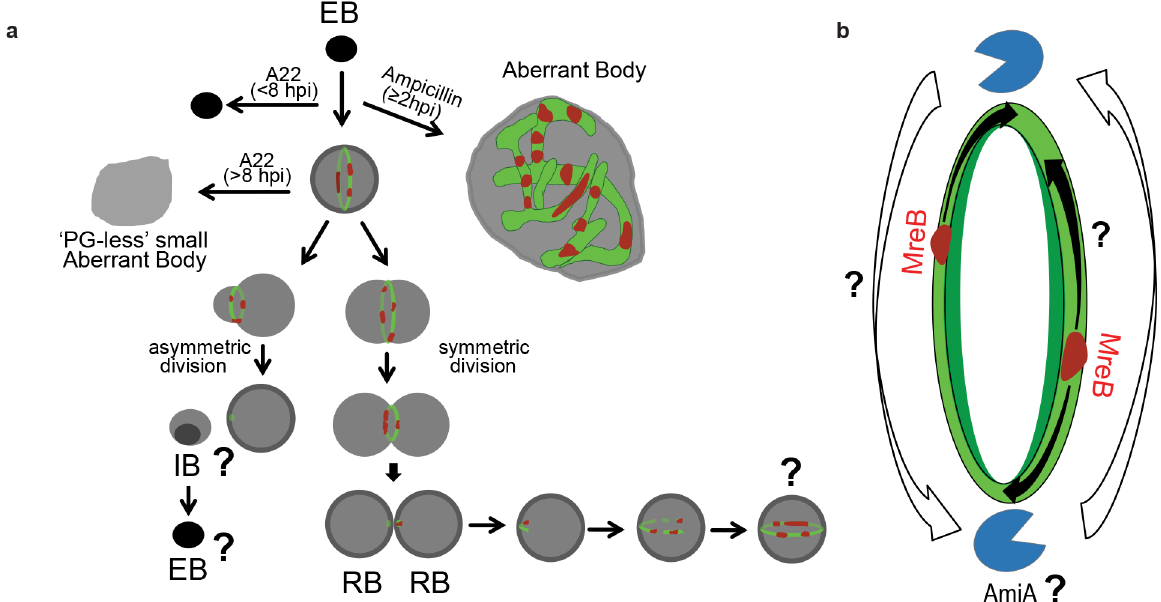
Fig 9. Proposed model for PG biosynthesis and maintenance in pathogenic Chlamydia . (a) Upon invading a host cell, MreB facilitates mid-cell PG (green) ring formation 8 hpi and the first cell division occurs. Inhibition of MreB (red) prior to EB-RB transition prevents this first division and results in accumulation of intracellular ‘ EB-like ’ particles in the host cytosol. Once RBs form, PG is constantly synthesized and incorporated into the ring non-uniformly by dynamic MreB patches. If MreB polymerization is inhibited, the PG ring dissociates, resulting in slightly enlarged, static, PG-less aberrant bodies. Inhibition of PG crosslinking by β -lactams does not affect transglycosylase activity and MreB localization, but instead results in unchecked enlargement of the RB. Bottom, upon cell division, the new division planes form immediately and perpendicular to the previous division plane. During transition to non-replicative EBs, MreB and PG biosynthesis enzymes are downregulated [58], resulting in the complete disassembly of the PG ring. (b) Chlamydial PG biosynthesis and degradation mechanisms overlap and are active throughout the cell cycle. MreB (red) moves along the ring plane (black arrows), initiating the non-uniform synthesis of new PG (green) and influencing the action of an unknown degradation mechanism that continuously removes older material (white arrows). PG degradation enzymes (amidases and lytic transglycosylases) are visualized as blue pacmen.